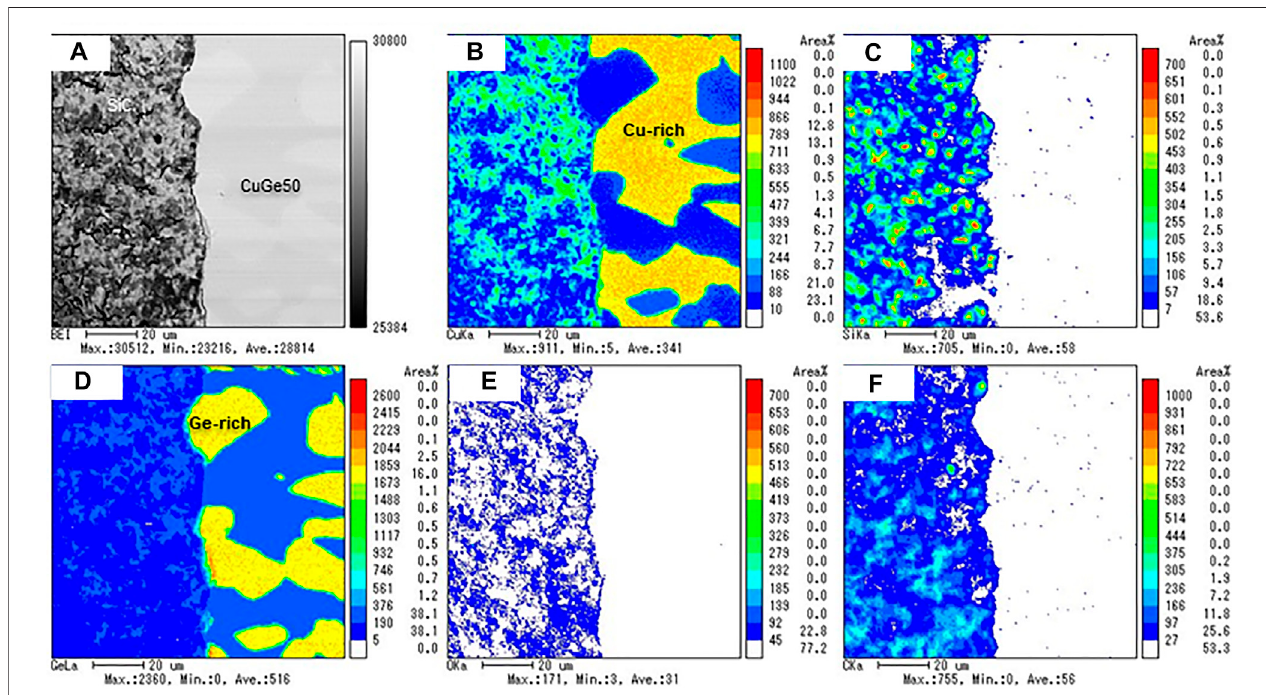
FIGURE 12 | The results of the EPMA analysis for the chemical compatibility test of CuGe50/SiC. (A) BEI image, (B) Cu, (C) Si, (D) Ge, (E) O, and (F) C mapping images.